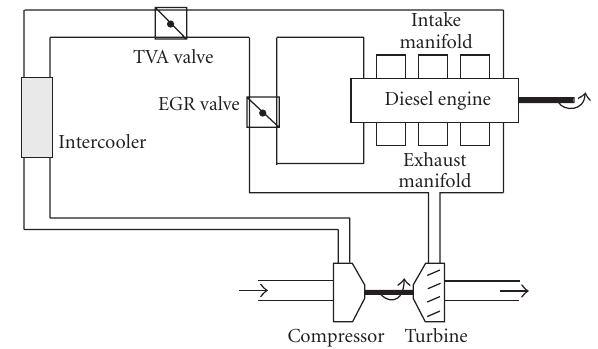
Figure 1: The diesel engine air